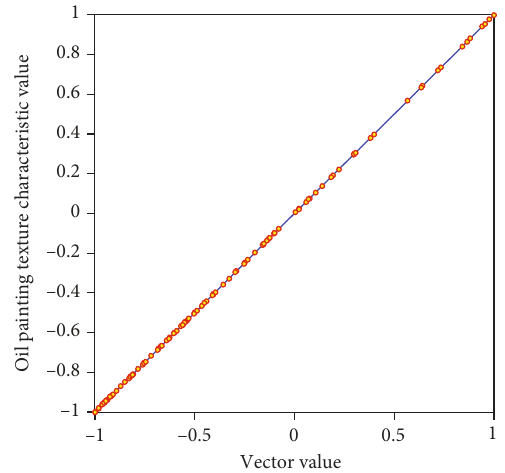
Figure 3: Fitting of the eigenvalues of oil painting texture with di ff erent